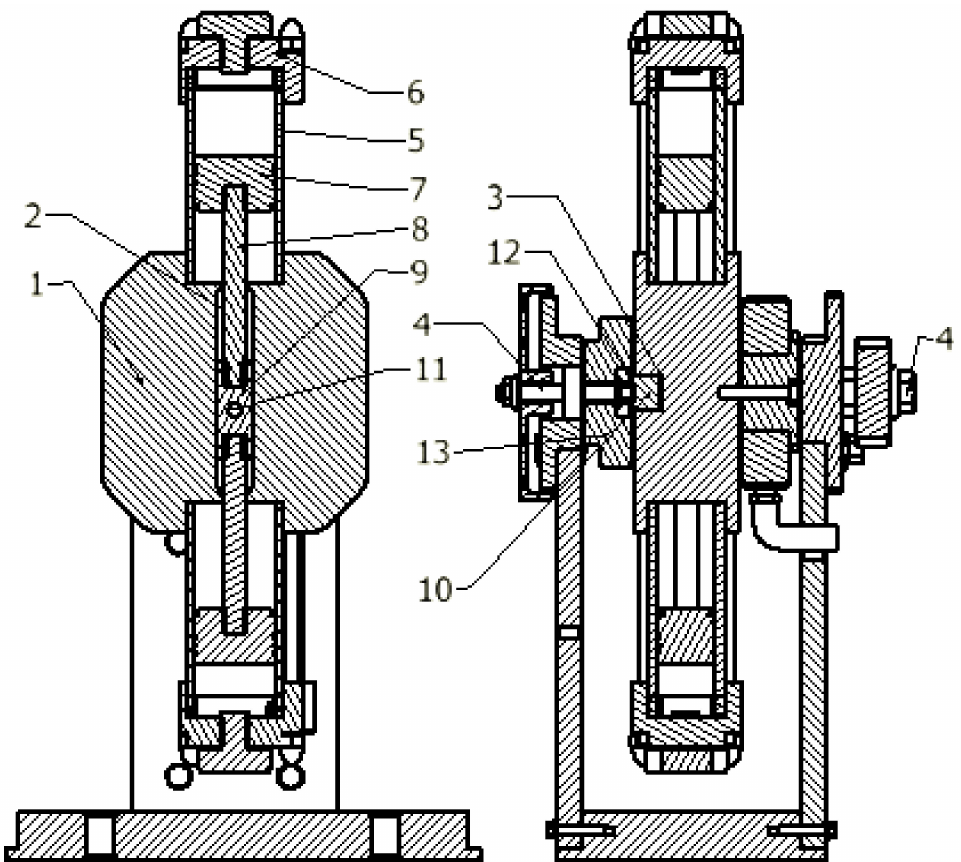
Figure 2. A cross section of the designed mechanism to illustrate the component